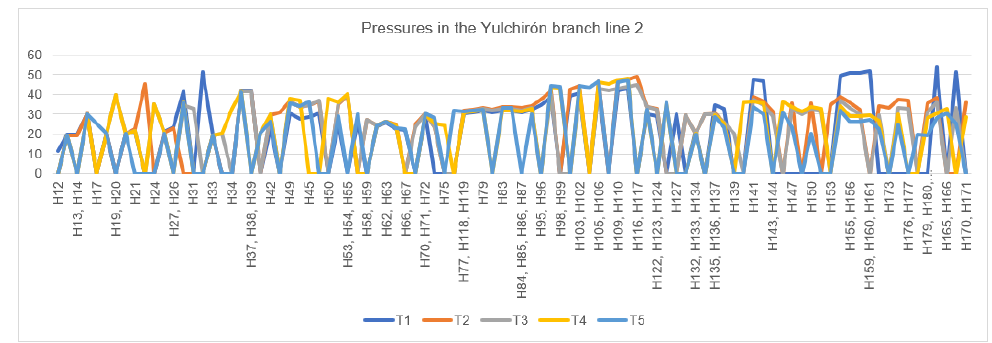
Figure 10. Pressure results, on the Yulchirón 2 branch operating in shifts. The minimum speeds on the lines of the Yulchirón 2 branch line are 0.39 m/s in shift